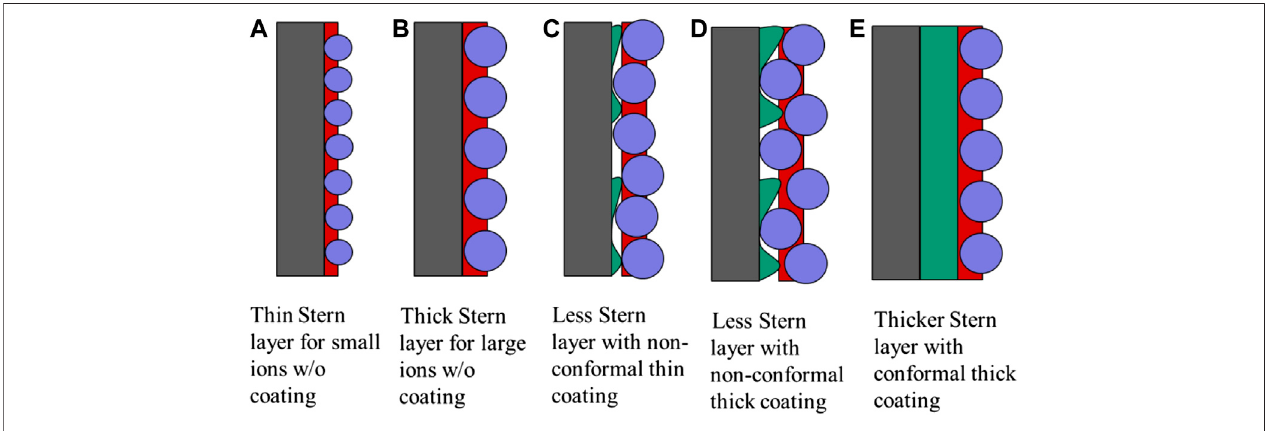
FIGURE 9 | Schematic illustration of the modi fi ed Stern layer